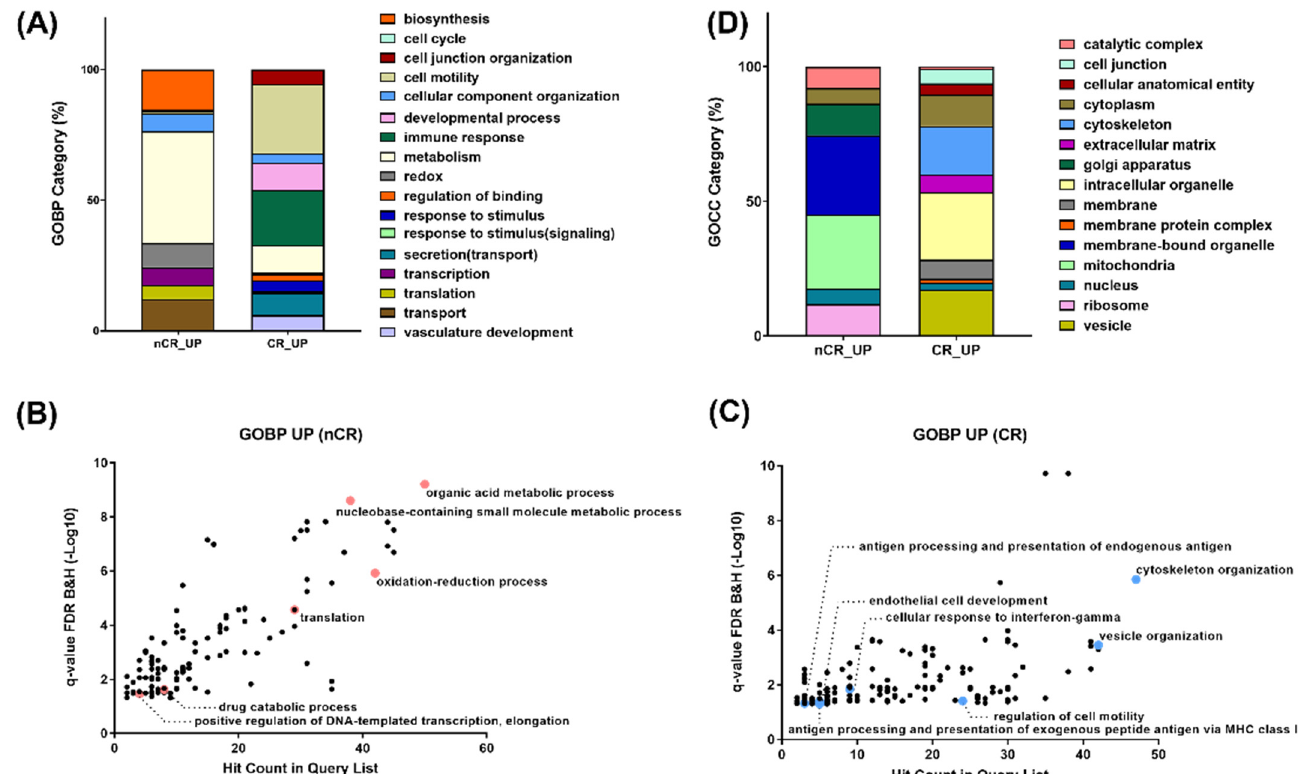
Figure 3. ( A ) Gene Ontology enrichment analyses on biological process on nCR ( B ) and CR ( C ) groups. ( D ) Gene Ontology enrichment analyses on cellular component.